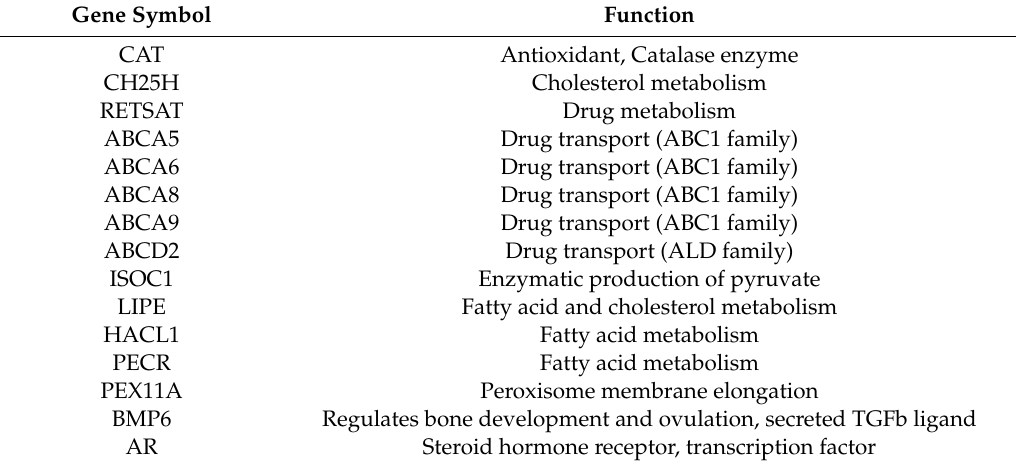
Table 6. Top 15 upregulated genes in post-NACT samples contributing to enrichment in the Hallmark Bile Acid Metabolism gene